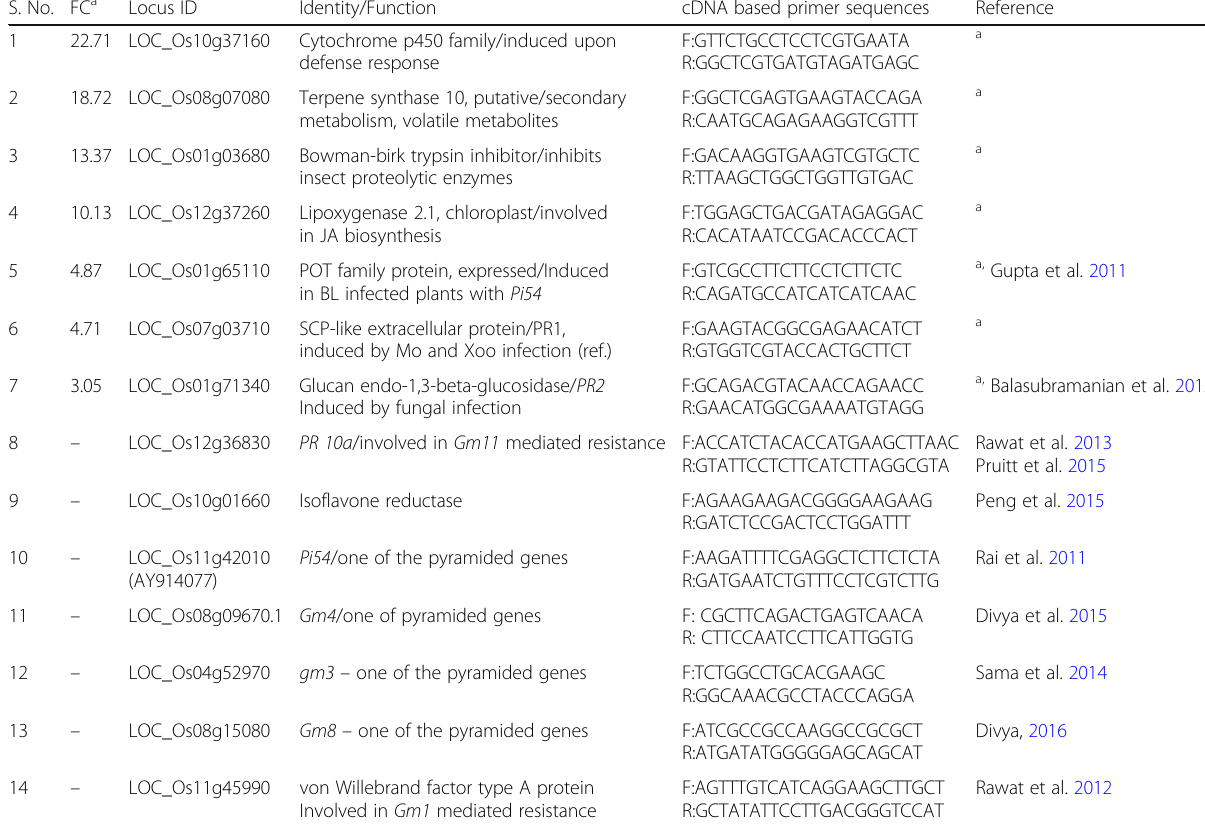
Table 2 Selected defense related genes used in validation studies and cDNA based primers S. No. FC